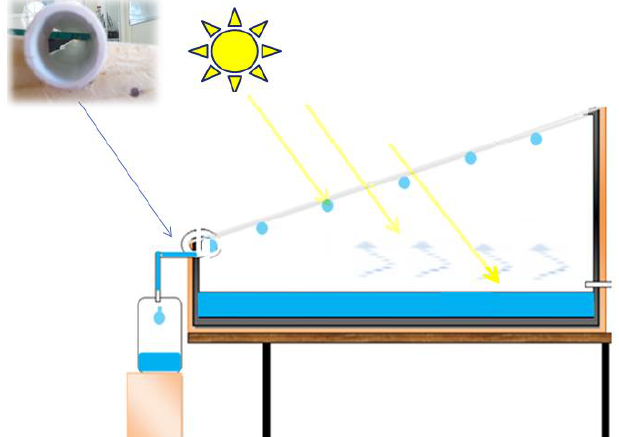
Figure 2. Operating principle of solar distiller